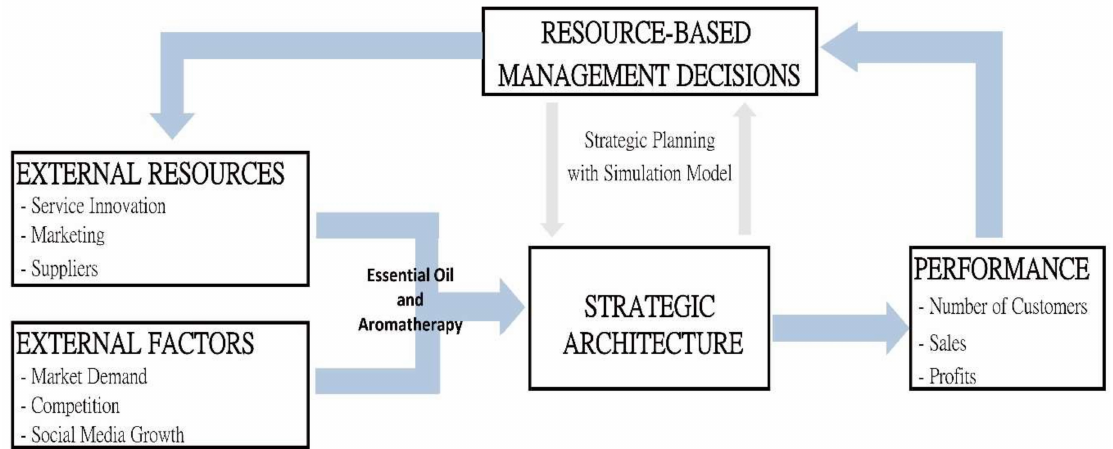
Figure 1. The applications of SSDSS for the Essential Oil and Aromatherapy